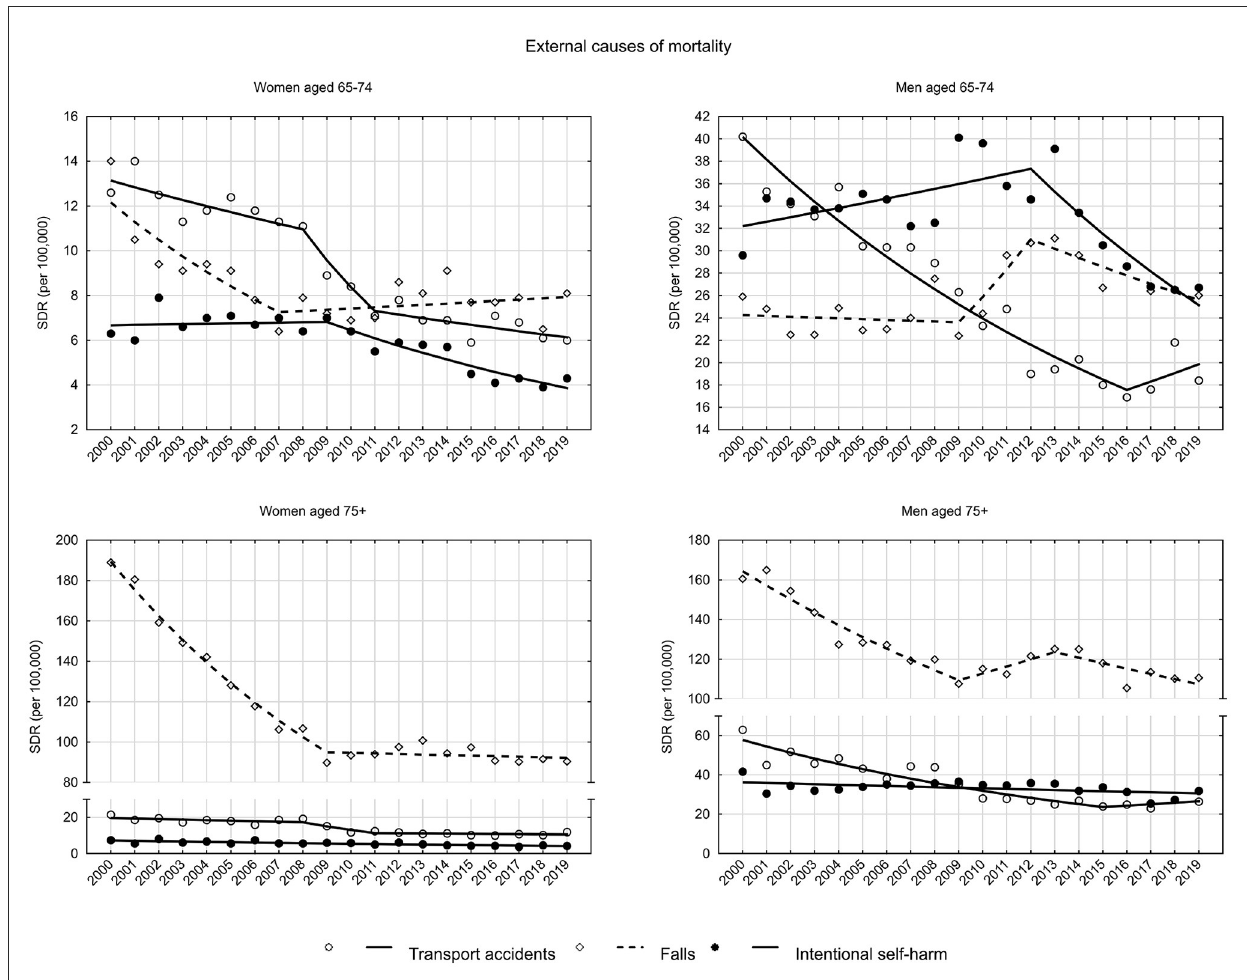
FIGURE5 SDR trends in the Polish population aged 65–74 years and 75 years and older due to external causes in the years